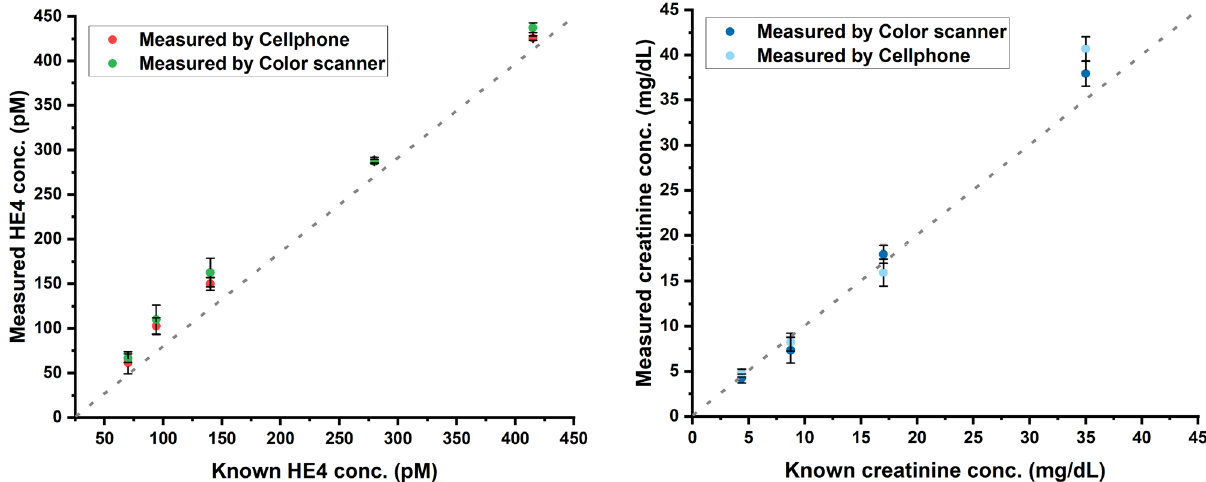
Figure 1. Comparison between flatbed scanner and cell phone measurement of HE4 concentrations (left) and of creatinine concentrations (right). Error bars the percent error found for each concentration (mean + s.d, n = 4). The dotted line indicates the line of identity. Error bars the percent